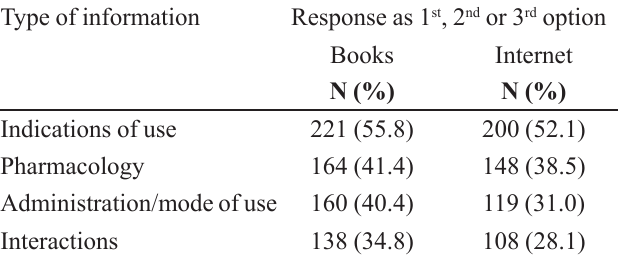
TABLE II – Main types of information searched in books